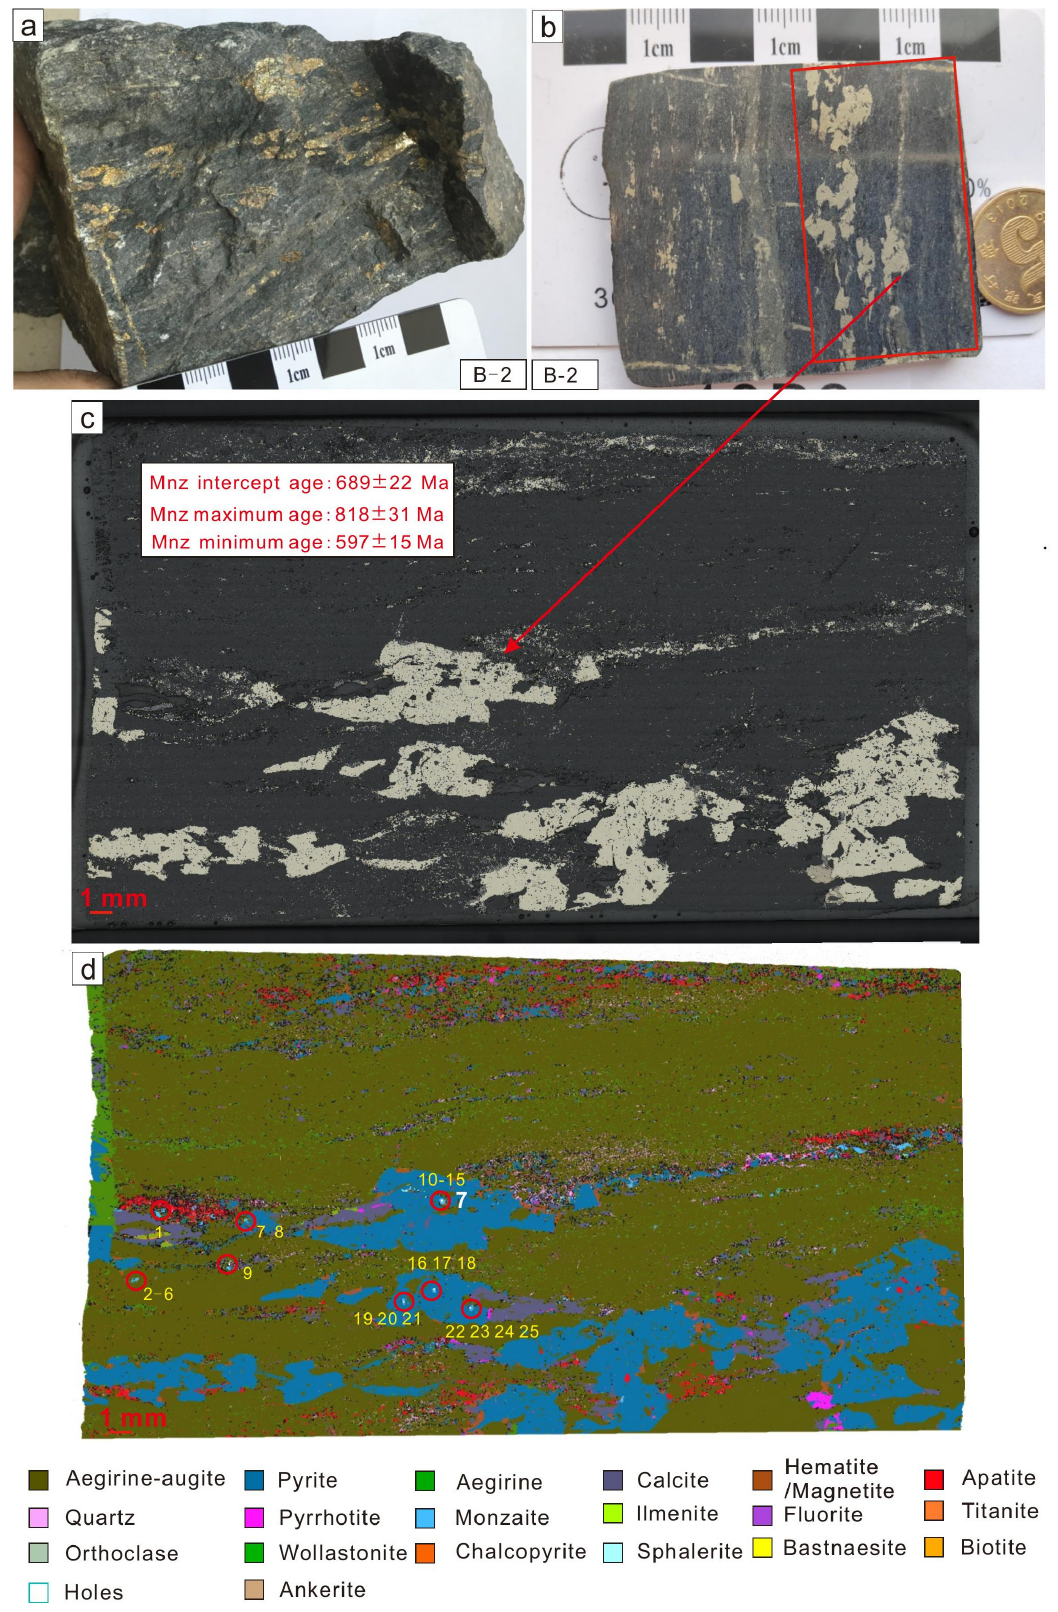
Figure 6. The petrological characteristics of sample B-2. ( a ) Hand specimen; ( b ) photograph of the polished surface of the sample; ( c ) panoramic photomicrograph under reflected light; ( d ) TIMA mineral maps. The red box in ( b ) is the location of the thin section of ( c ).